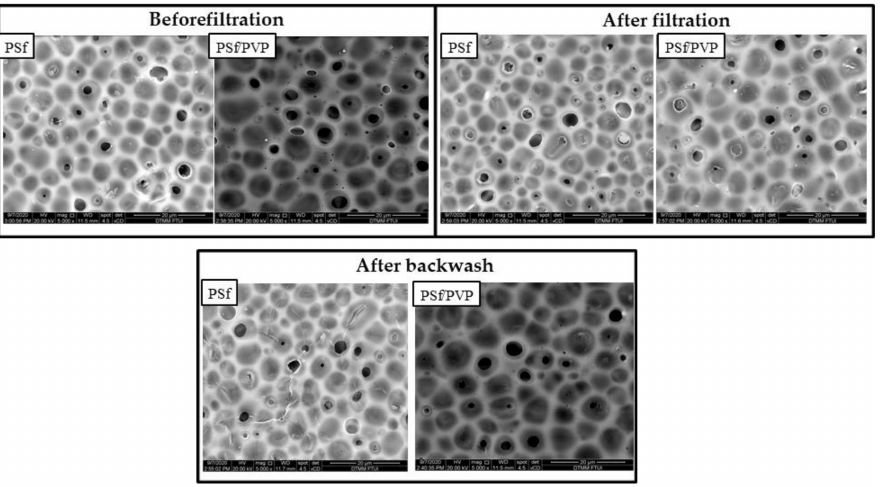
Figure 13. Comparison of FESEM on the pristine PSf and PSf/PVP blend polymer composite membrane before filtration, after filtration, and after